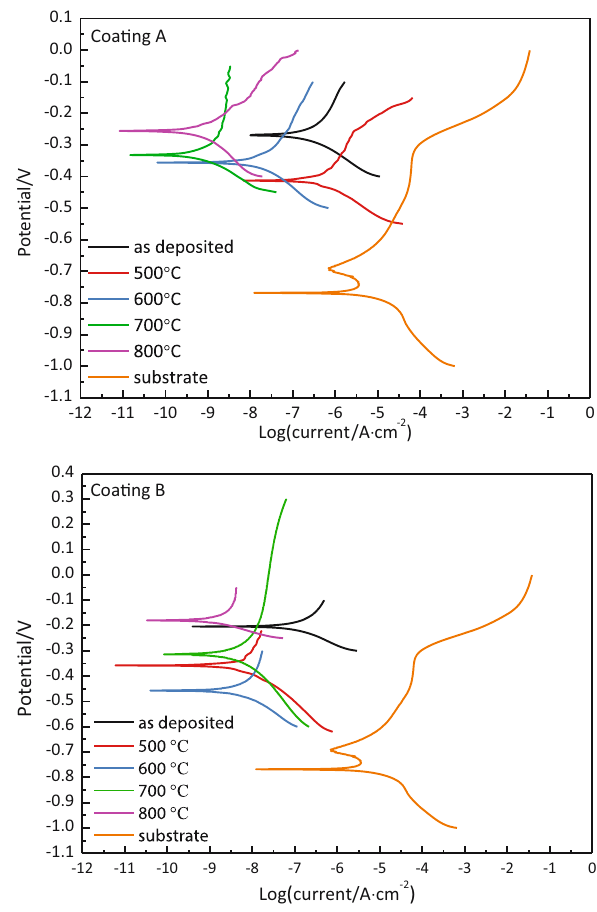
Figure 10: The polarization curves of coating A and coating B oxidized at di ff erent temperatures in 3.5% NaCl solution.